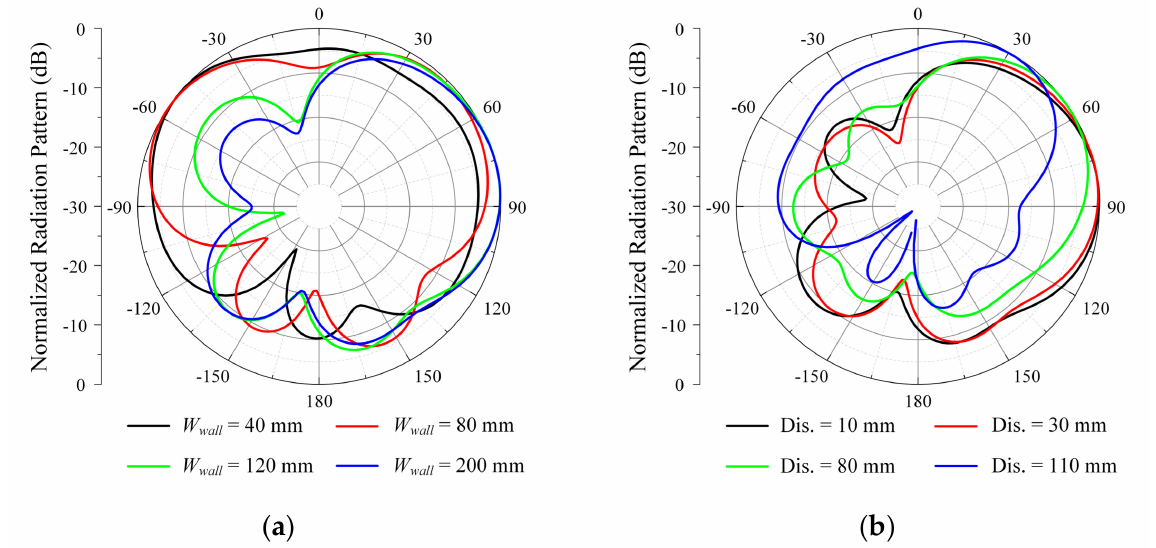
Figure 7. Simulated normalized patterns of the IFA in the xz plane according to ( a ) the metallic wall size (distance = 20 mm) and ( b ) distance ( W wall = 200 mm).